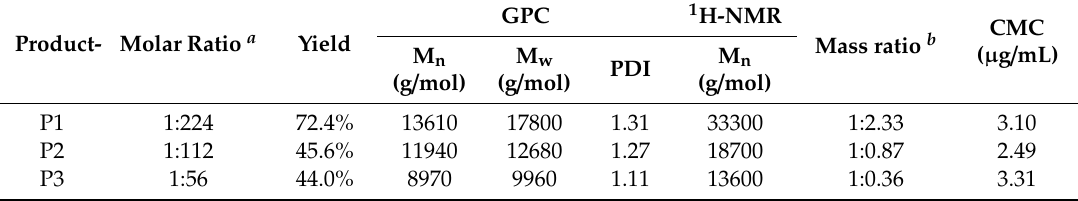
Table 1. Materials’ properties of P1 , P2 , and P3 . GPC: gel permeation chromatography.